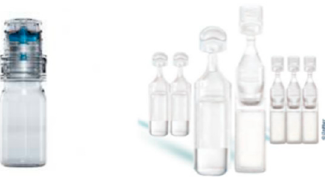
Figure 1. Preservative free multidose and BFS monodoses.